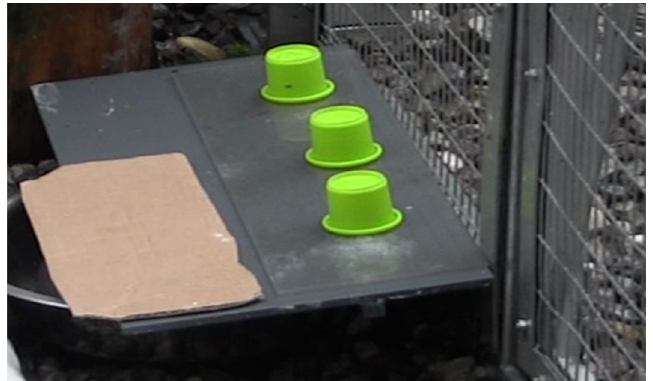
Figure 2 Experimental set-up. Figure 2 shows a picture of the experimental set-up with the experimental board located on two stone blocks, a transparent sliding board, and testing material (three green cups) in front of the bird’s experimental